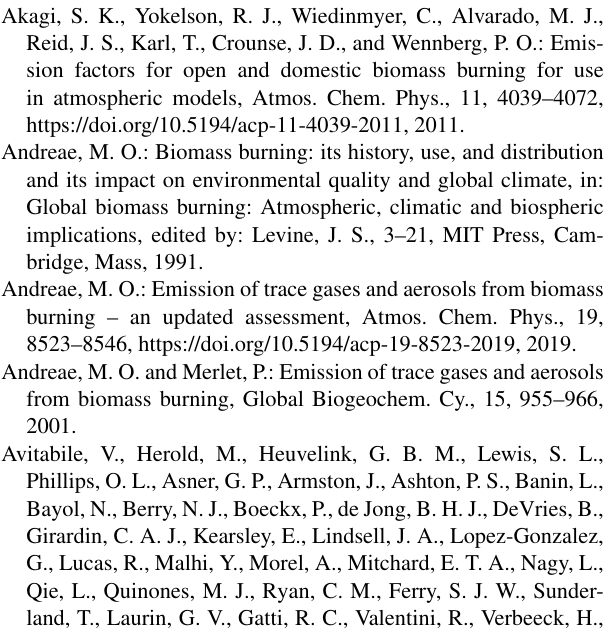
Permanent snow and